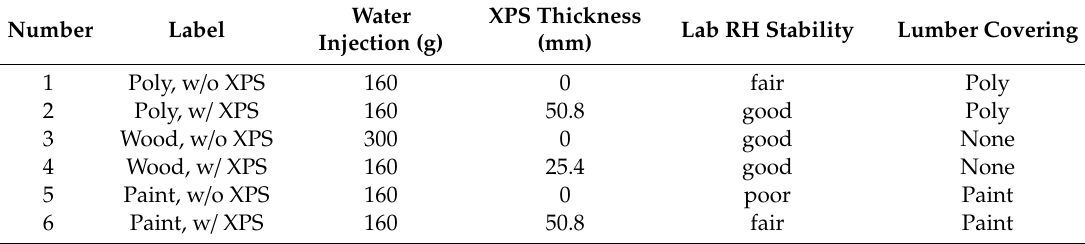
Figure 1. Side and front view diagram of wall construction. Points 1 through 7 represent placement of moisture pins. Table 1. Summary of conditions for wall drying experiments.